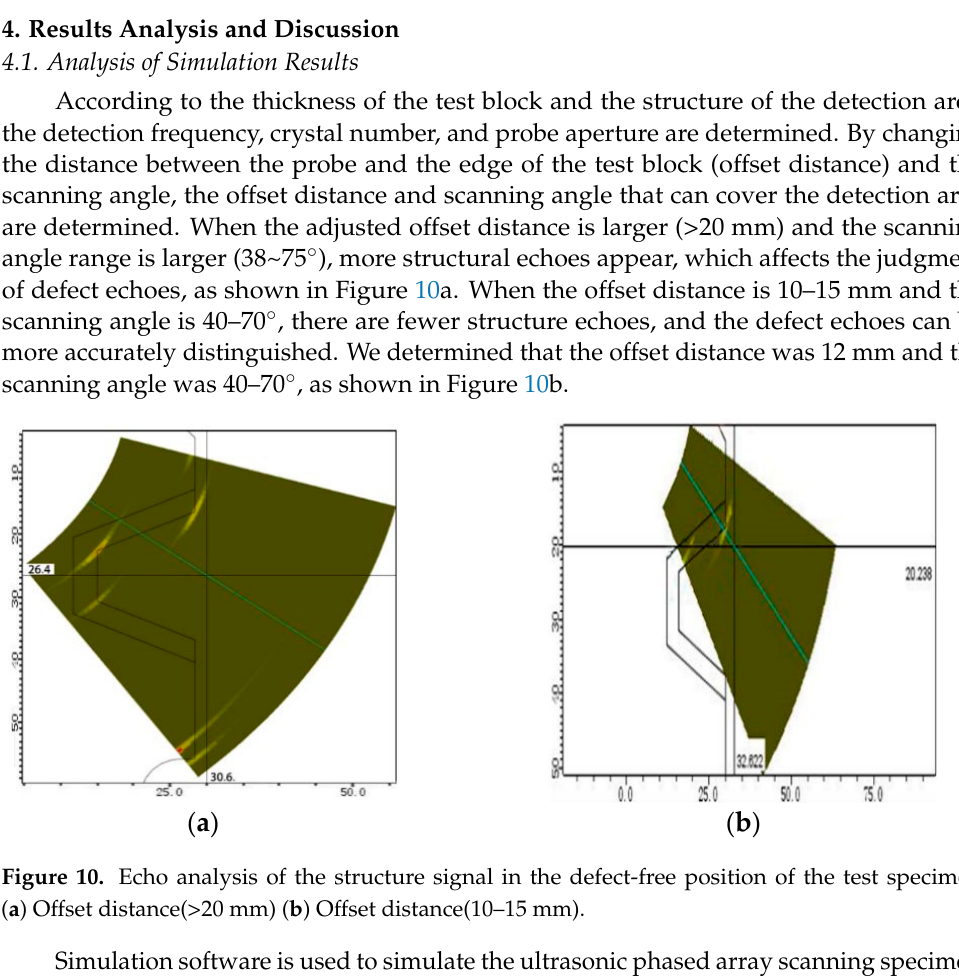
Figure 9. Ultrasonic phased array field test.